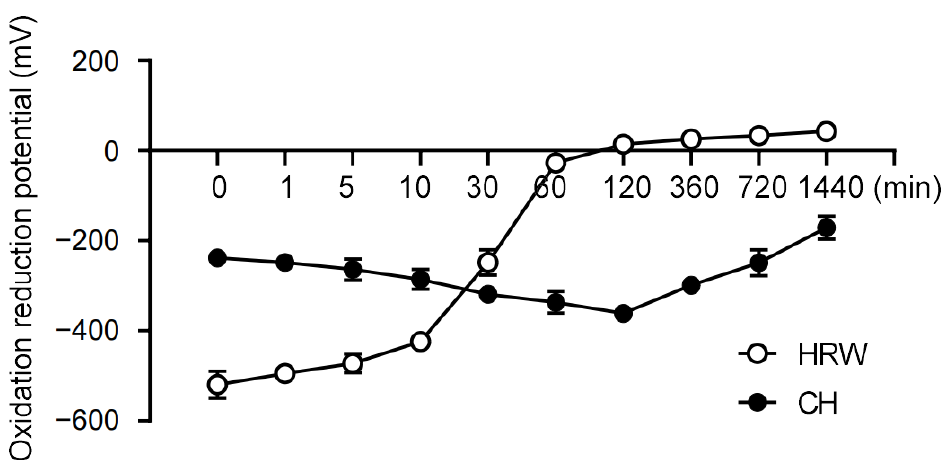
Figure 1. Coral hydrate has stable redox potential. The redox potentials of hydrogenated water (HRW), and coral hydrate (CH; 100 mg in 10 mL MQ) were measured using oxidation/reduction electrodes at the indicated times.